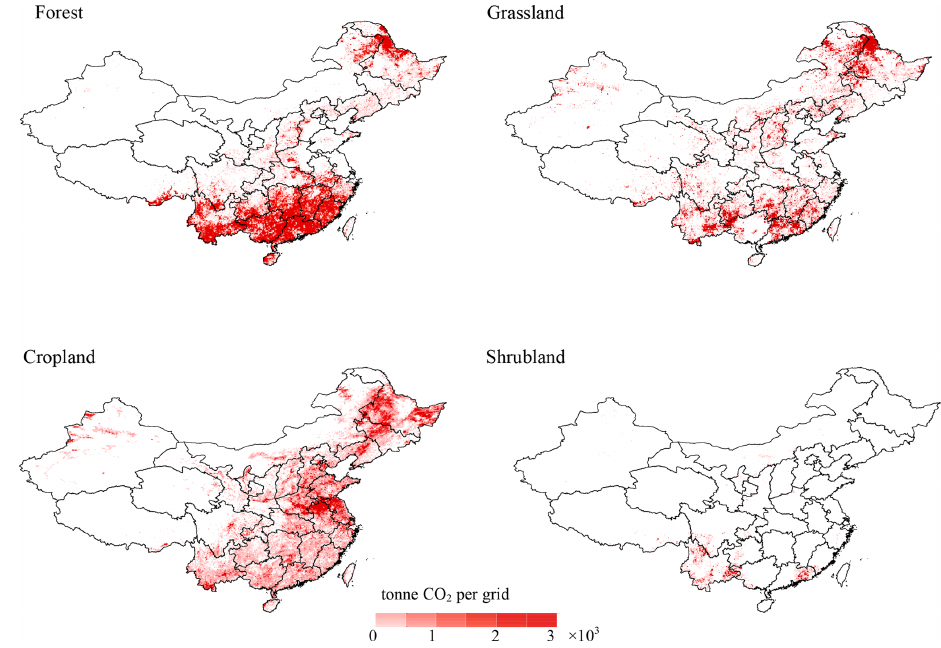
Figure 2. Spatial distribution of CO 2 emissions (tonne) from each land-cover type (excluding small islands in the South China Sea).